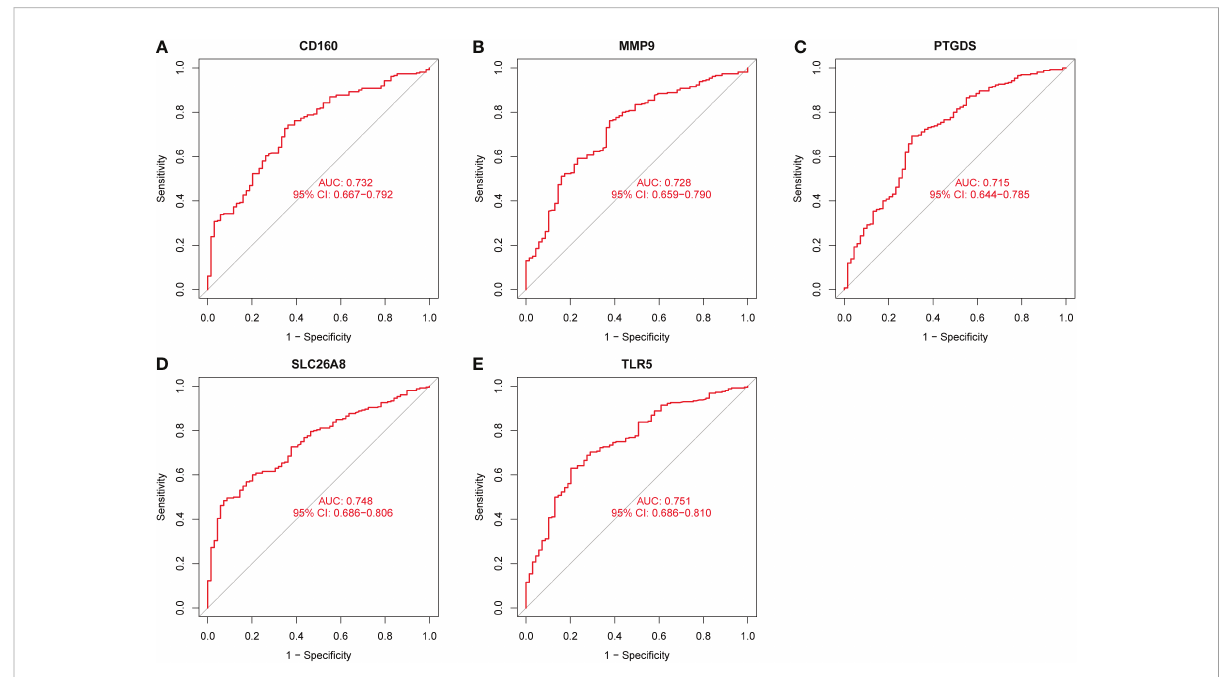
FIGURE 4 The receiver operating characteristic (ROC) curve of the diagnostic effectiveness of the fi ve diagnostic markers. (A) ROC curve of CD160. (B) ROC curve of MMP9. (C) ROC curve of PTGDS. (D) ROC curve of SLC26A8. (E) ROC curve of